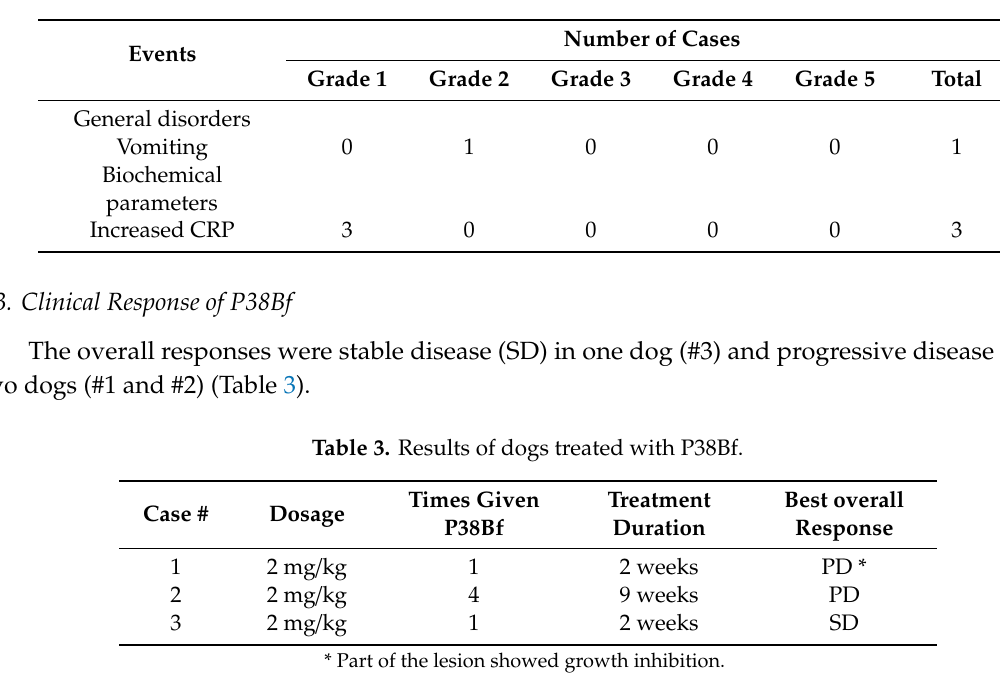
Table 2. Treatment-related adverse events of P38Bf administration.